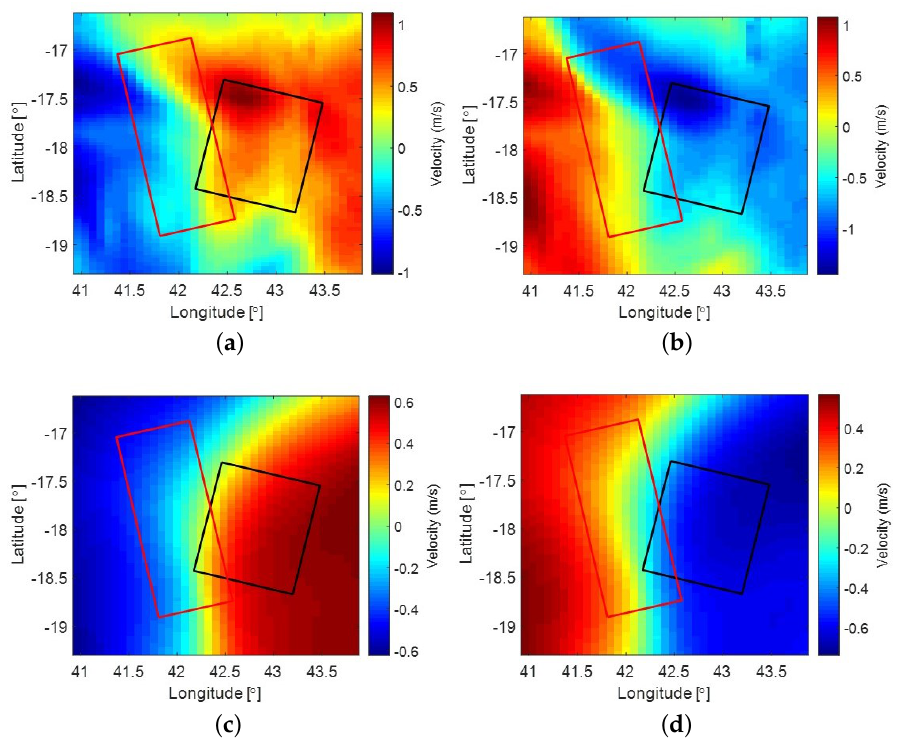
Figure 7. ( a ) Sea-surface radial velocity along the ascending beam. ( b ) Sea-surface radial velocity along the descending beam. ( c ) Wave velocity along the ascending beam. ( d ) Wave velocity along the descending